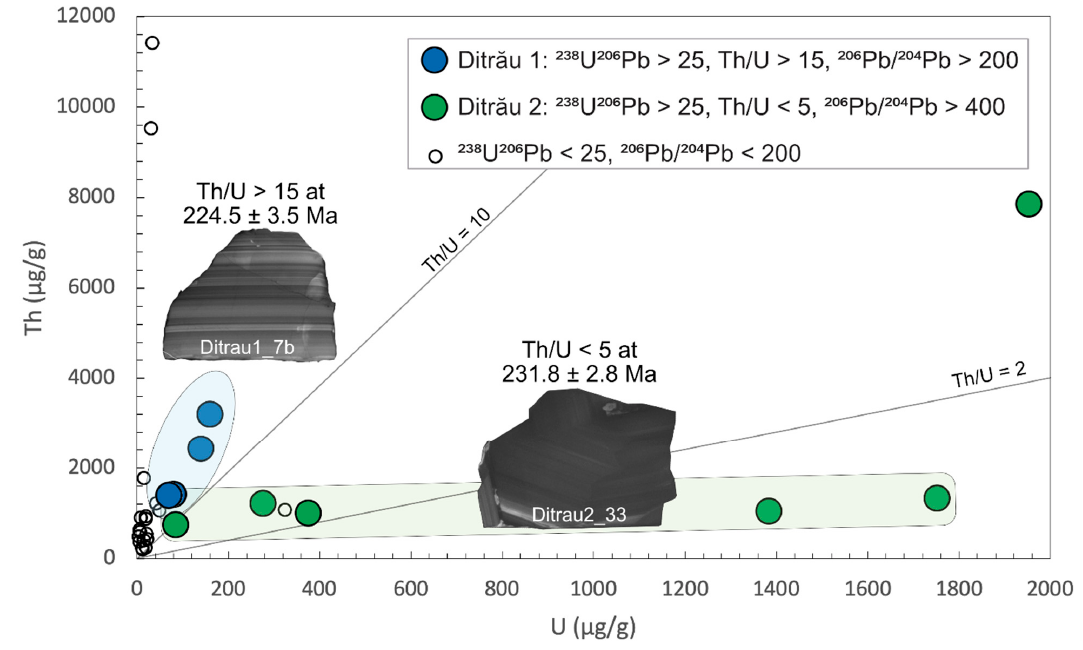
Figure 8. Plot of U versus Th showing the chemically different zircon domains relevant to the age 238 U/ 206 Pb > 25, Th/U > 15, and 206 Pb/ 204 Pb > 200 define a U-Pb concordia age of 224.5 ± 3.5 Ma (blue array). These spots are related to intermediate bright CL zircon domains with